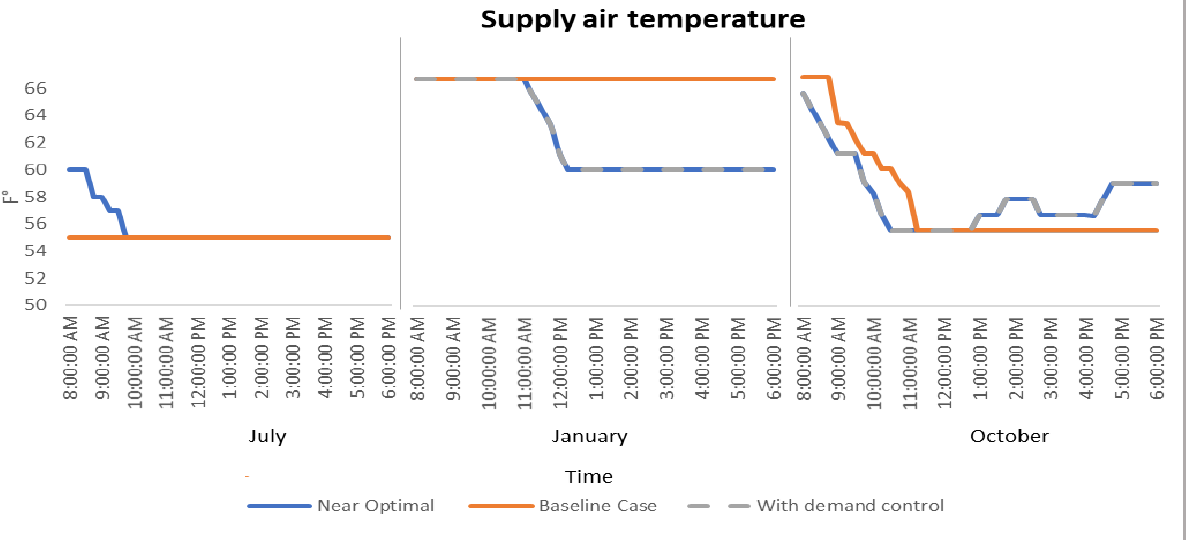
January. At the same time, the near-optimal supply air temperature was 65 °F (18.3 °C) in